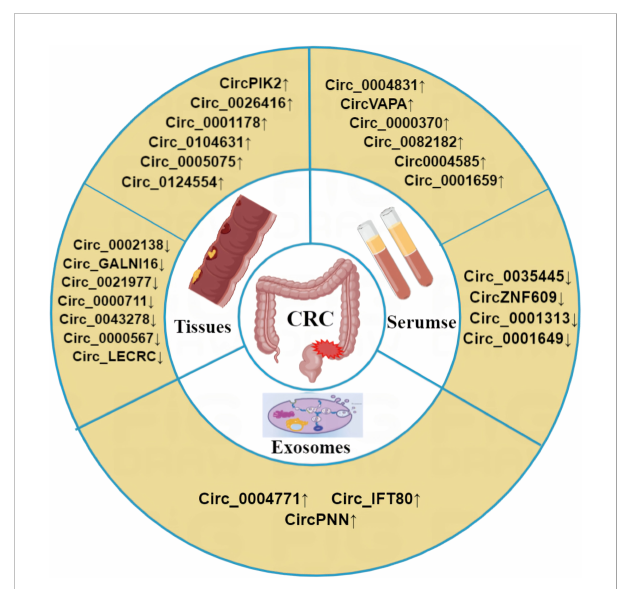
FIGURE 4 Abnormal expression of circRNA in CRC. Compared with the normal control group, circRNA was differentially expressed in CRC tissues, exosomes and blood of CRC patients. ‘ ↑ ’ means up, ‘ ↓ ’ means down.